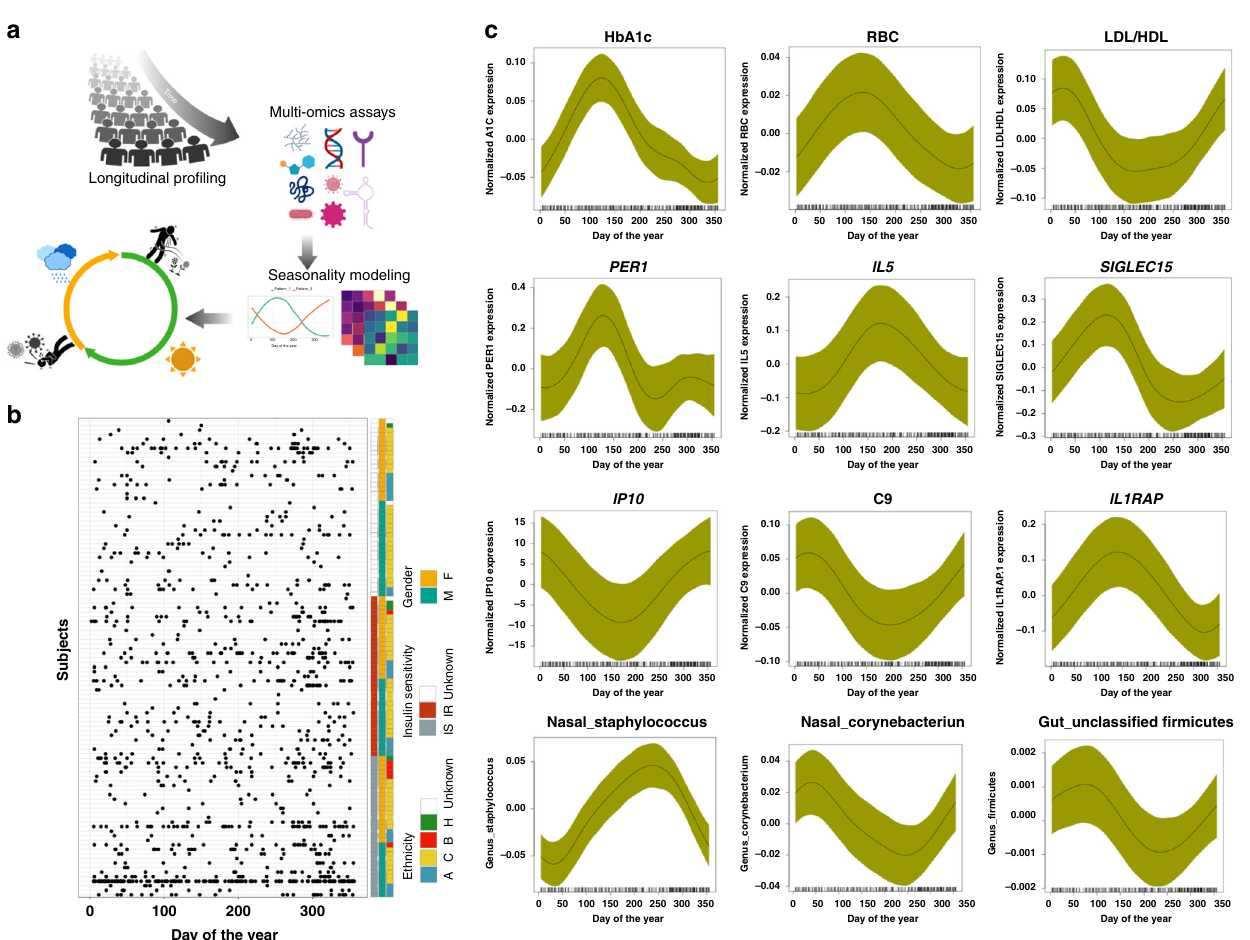
Fig. 1 Study design and seasonality. a . Integrative personal omics pro fi ling (iPOP) cohort sampling and data collection for seasonal analyses. Omic assays included immune molecules pro fi ling using Luminex assay, proteomics using sequential windowed acquisition of all theoretical fragment ion mass spectrometry (SWATH-MS), metabolomics using liquid chromatography (LC) — mass spectrometry, transcriptomics and microbial pro fi ling (gut and nasal) using next-generation sequencing, in conjunction with clinical lab tests and meteorological measurements. b Subjects and sampling timepoints for each individual, as well as ethnicity (A: Asian, B; Black, C; Caucasian), insulin sensitive (IS) and insulin resistance (IR), and gender information (M: Male, F: Female). c Examples of omics analytes with seasonal patterns (transcripts, cytokines, metabolites, proteins, clinical lab tests, gut and nasal microbiome). The X- axis shows the days of the year (1 – 365 days) and Y- axis shows the normalized expression/abundance values. The samples are collected up to 4 years and aggregated and mapped to 1-year-long time frame. The shaded area represents 95% con fi dence bounds computed as ±1.96 standard deviation of model coef fi cients. Standard deviations were derived from a maximum likelihood fi